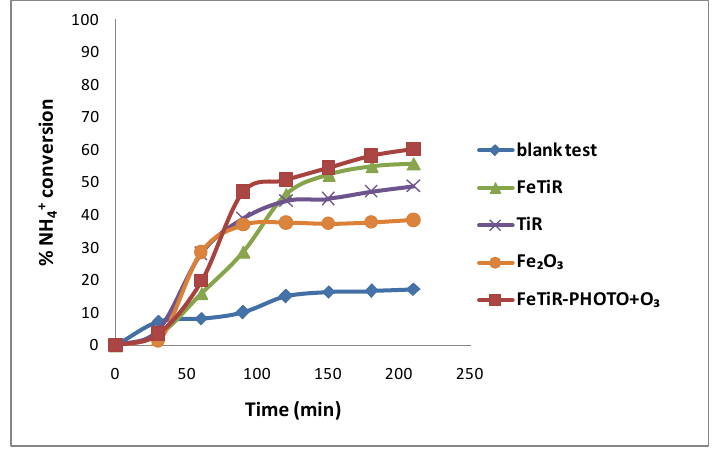
Figure 13. NH 4+ conversion for catalytic oxidation with ozone and combined photo-assisted degra- dation pathway (for FeTiR catalyst).